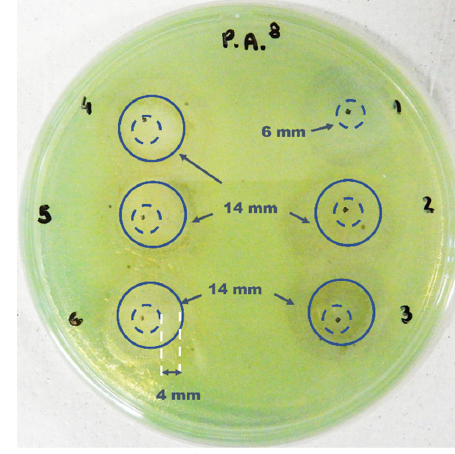
pyogenes . The numbers indicated on the plates correspond to pure PVA and PVA films with Polymers 2022 , 14 , 3588 different concentrations of Ag particles, as described in Table 4.